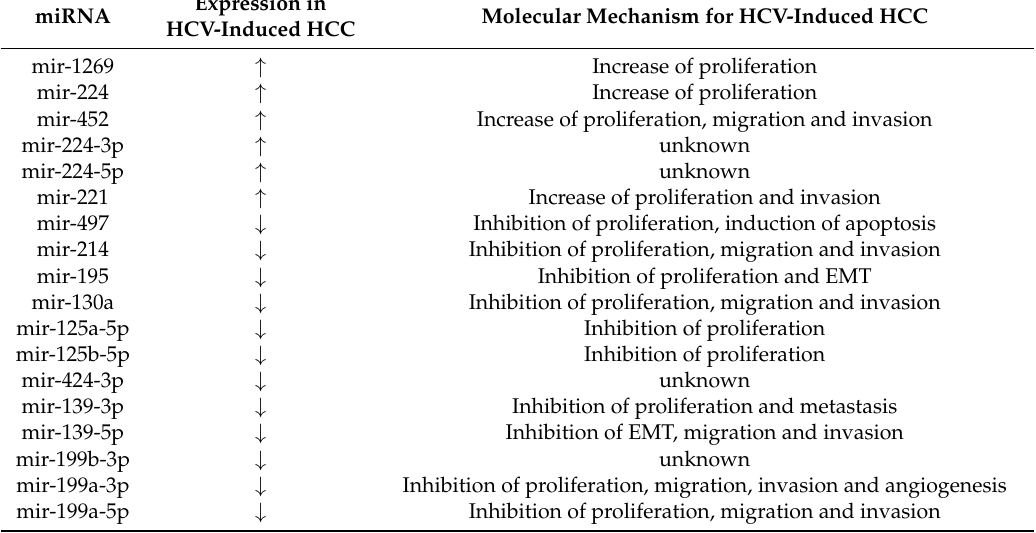
Table 2. miRNA-specific signature of HCV-induced HCC. The expression of miRNAs that have been associated with HCV-induced HCC [42], as well as their biological function, are